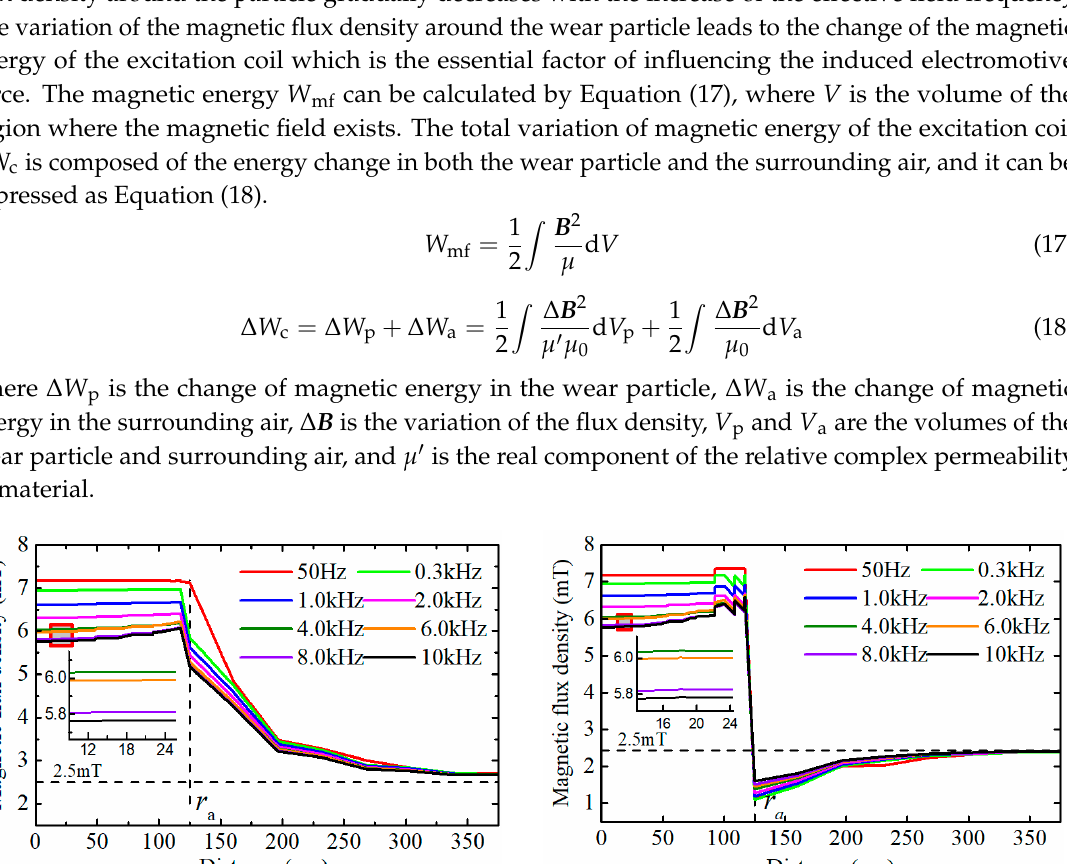
Table 1. The relative complex permeability of material under different field frequencies.